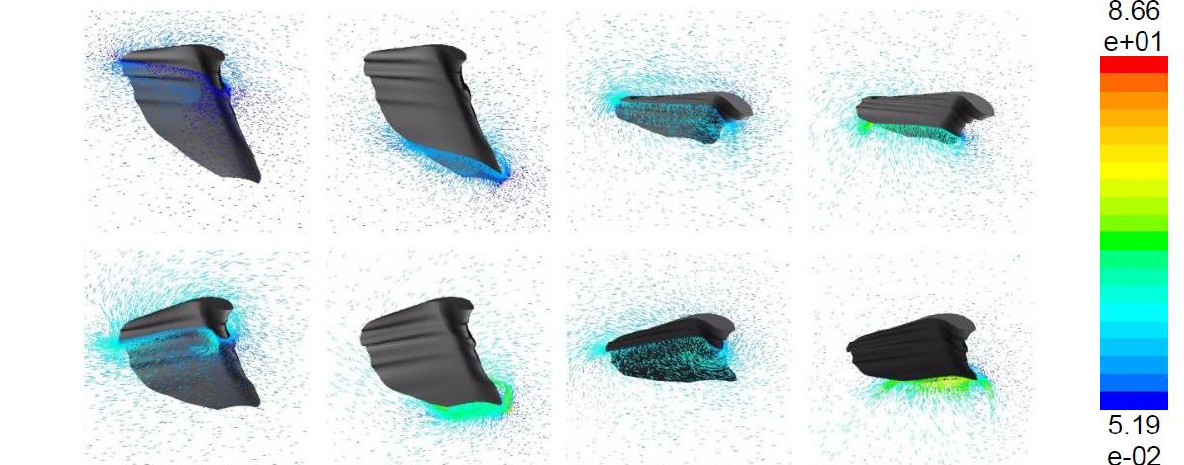
Figure 13. Vector plot of lift production with respect to stroke cycle for ( a ) corrugated rigid ( top ) and ( b ) flexible wing ( bottom ). The analysis is performed at 4.4 m/s, highest flapping frequency (21 Hz) at 12° angle of attack.